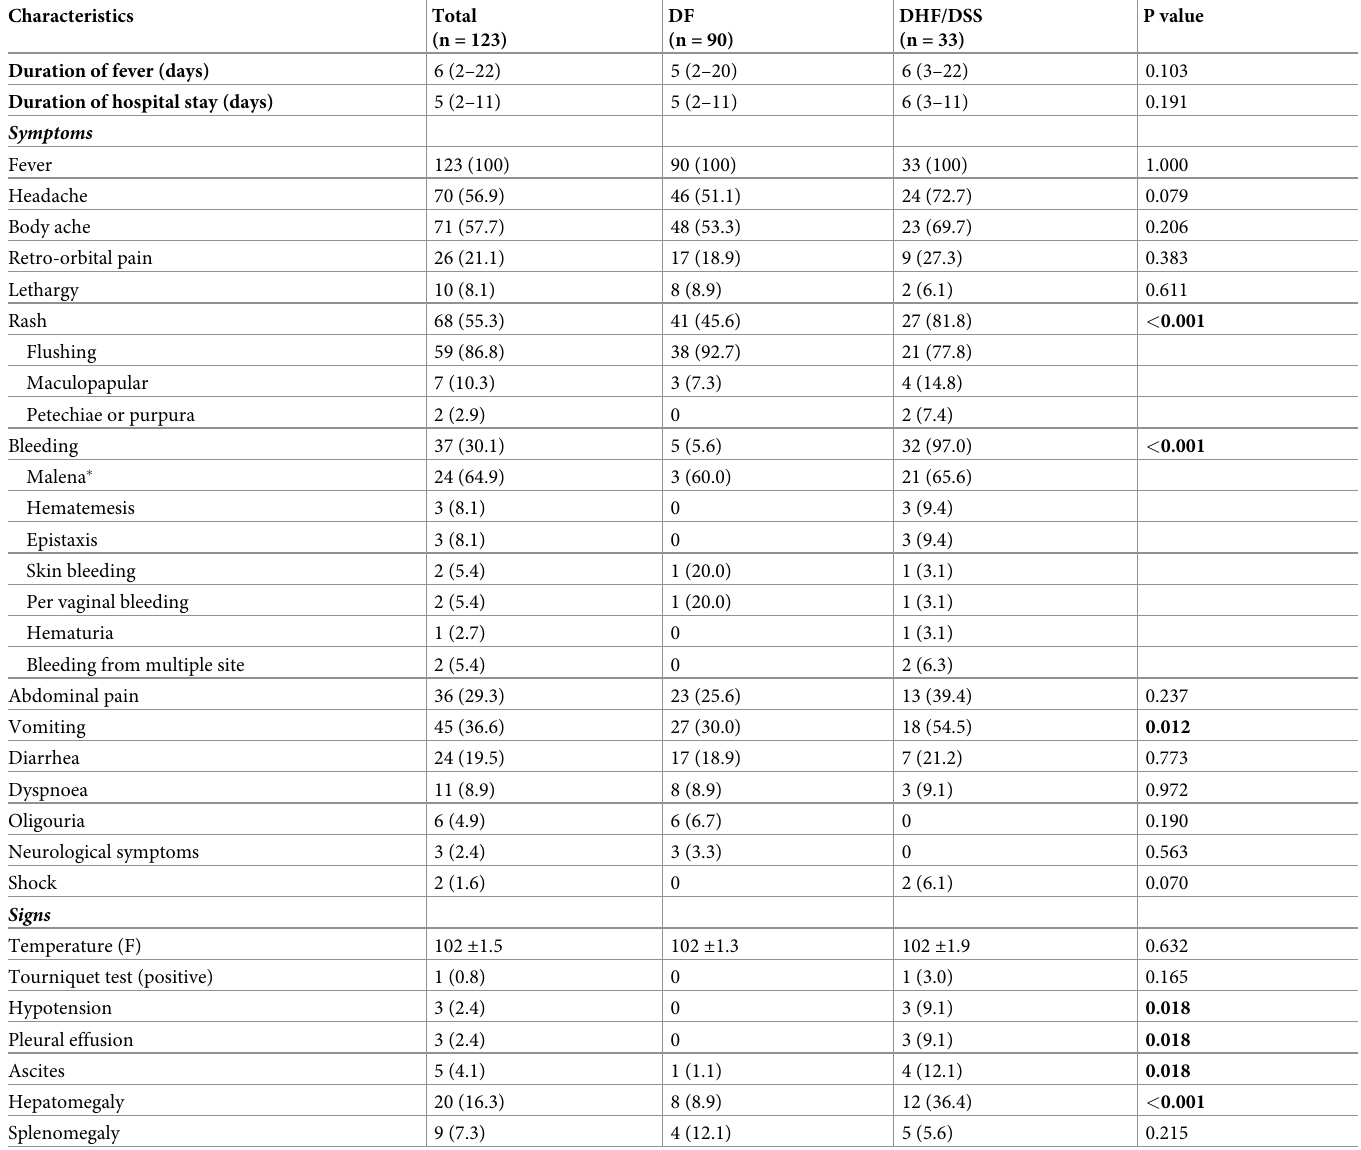
Table 2. Clinical features of children with dengue at